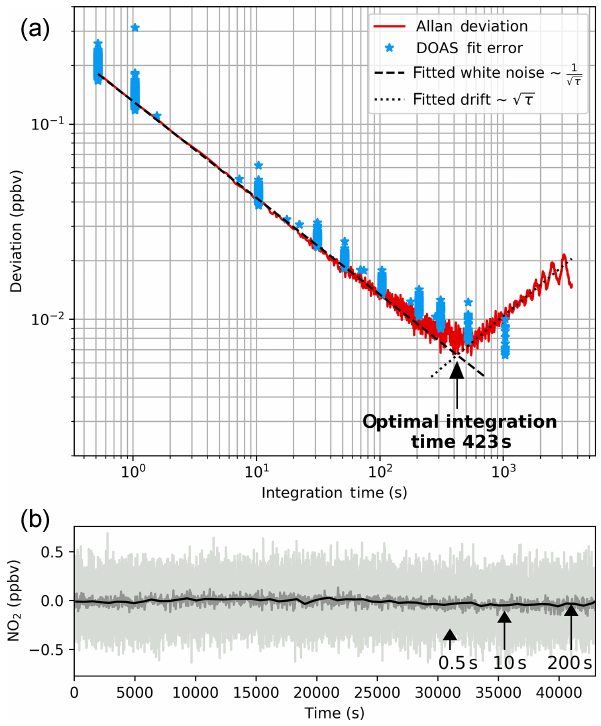
Figure 8. Results from long-term zero-air measurements, recorded with instrument config 2. They are used to examine the instrument performance at different integration times. Spectra were recorded at 0.52s integration time. Signal averaging was applied to cre- ate further time series with longer integration times up to 3591s. ICAD evaluation was applied to the spectra according to Table 1. Panel (b) shows the time series for different integration times. Panel (a) shows the 1 σ Allan deviation as a function of integration time. We used its minimum to determine an optimal integration time of 423s. Beyond this point signal averaging does not improve the in- strument performance due to drifts and non-white noise. Also, the 1 σ DOAS fit error is shown, which also shows an optimal 2 σ de- tection limit of 0.02ppbv in